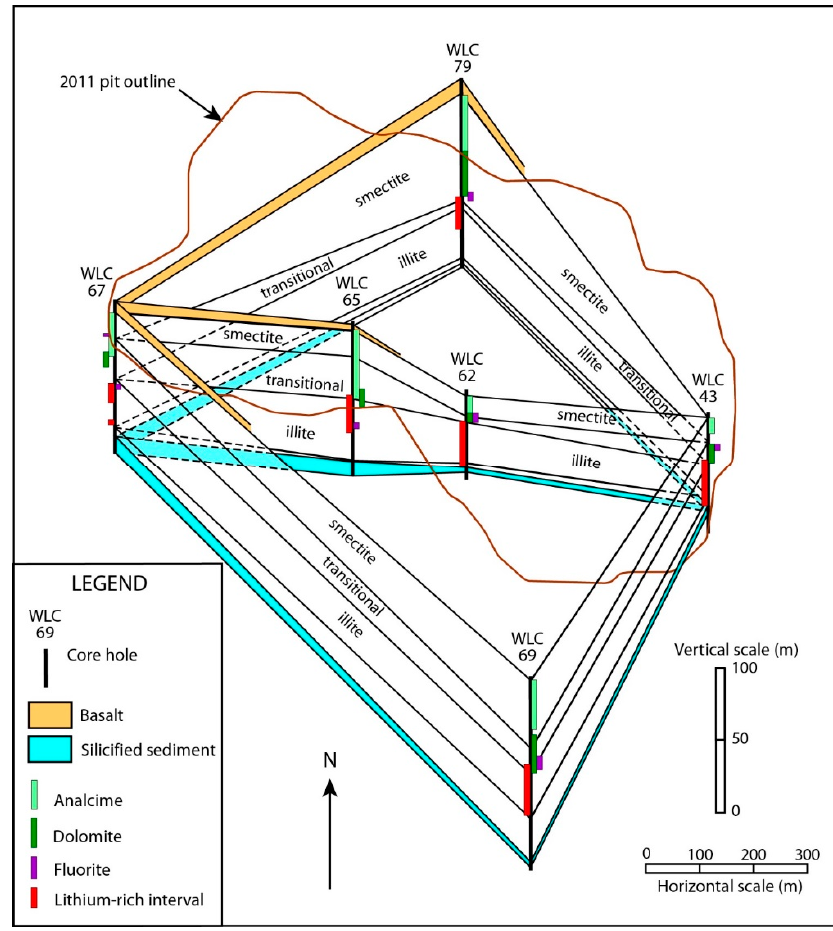
Figure 6. Fence diagram of drill holes with mineral zones. 2011 pit outline and drill hole locations are from Lithium Nevada’s Thacker Pass Project (Figure 5). Hole collar locations are in the same horizontal plane as the pit outline.